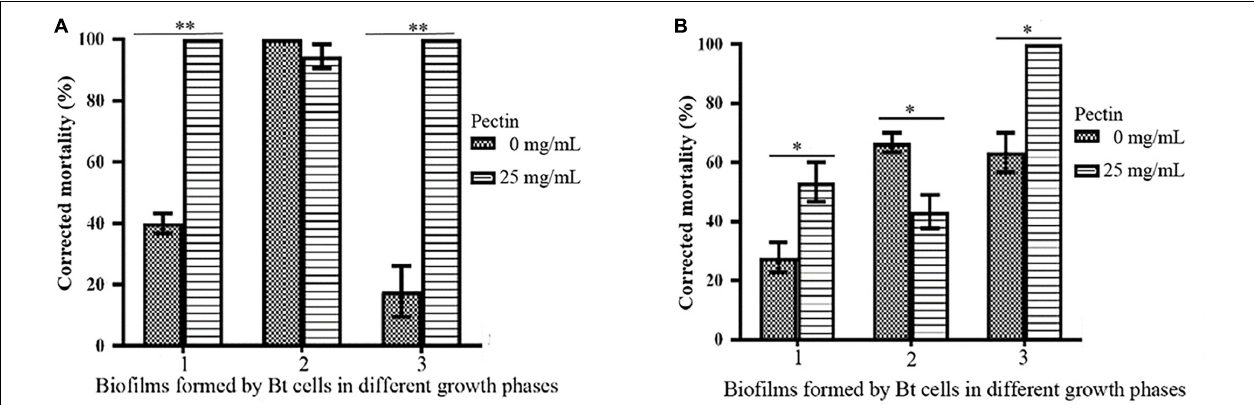
FIGURE 8 | Effects of pectin on the toxicities of biofilms formed by Bt cells in different growth phases. (A) HD1. (B) HD73. 1, 2, 3: Biofilms formed by Bt cells in the logarithmic growth phase, the sporangial phase, and the lysis phase, respectively. * and ** represent a significant difference and an extremely significant difference between the biofilms formed by the Bt strains without or with pectin induction,